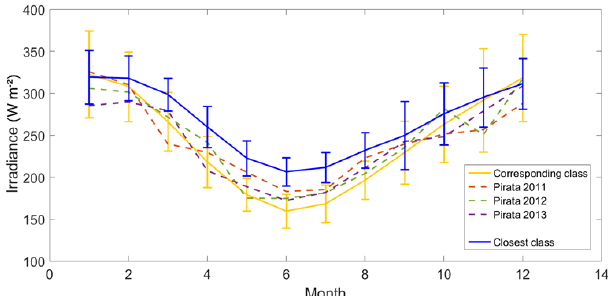
Figure 4. Yearly profiles of DSIS for the mooring at latitude 19 ◦ S and longitude 34 ◦ W for 2011 to 2013. Yellow: typical profile of the corresponding class, the intervals denote the envelope of the varia- tion within the class; Red: PIRATA measurement for 2011; Yellow: PIRATA measurement for 2012; Purple: PIRATA measurement for 2013; Blue: typical profile of the class which is the closest to the